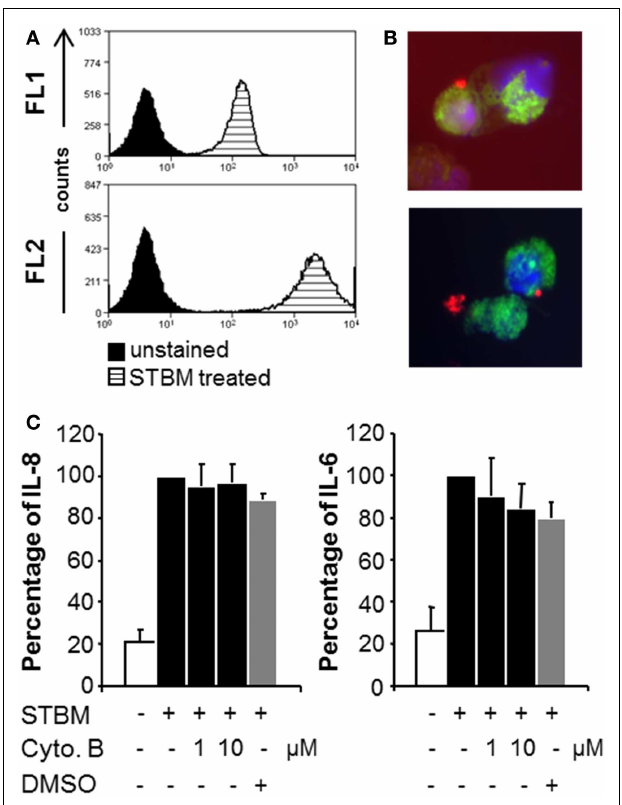
FIGURE 3 | STBM interact with monocytes, but phagocytosis is not required for their stimulatory properties. PKH-26-labeled STBM-NP (300 µ g/ml) were incubated with monocytes for 16h and analyzed by flow cytometry or fluorescence microscopy. (A) Representative histograms of CD14-positive monocytes read in the FL1 (CD14) and FL2 (PKH-26) channels. (B) Fluorescence microscopy of CSFE-stained monocytes (green) incubated with PKH-labeled STBM (red). DAPI (blue) was used as a nuclear counterstain. (C) Monocytes were pre-treated with various concentrations of cytochalasin B in DMSO or with DMSO alone, prior to the addition of 300 µ g/ml STBM.The levels of IL-8 and IL-6 secreted by the cells after 16h of incubation are expressed as a percentage of the amounts produced by cells stimulated with STBM in the absence of the inhibitor, which was set at 100%. Data represent mean ± SEM of three different co-cultures with STBM-NP prepared from three placentas.There was no statistical difference between cytokine secretion in the absence or in the presence of cytochalasin B.